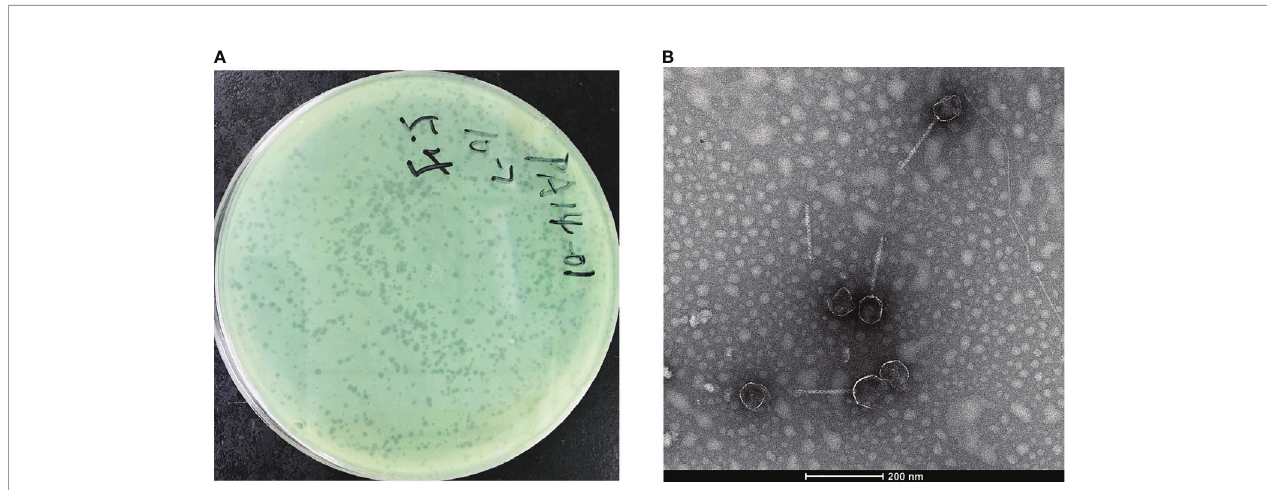
FIGURE 2 | Morphological images of PAJD-1. (A) Single-plaque in a double-layer agar plate. (B) Transmission electron microscopy image of